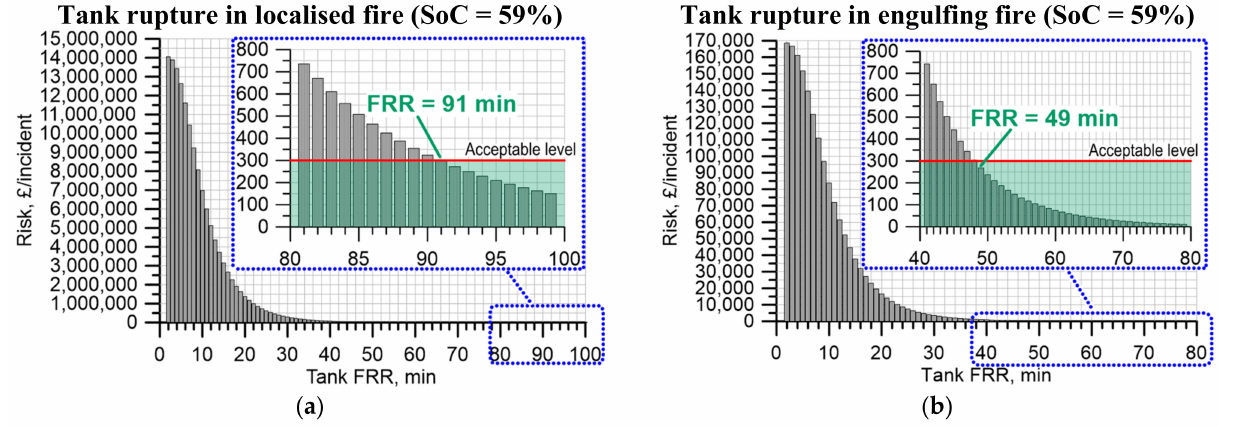
Figure 5. Risk (GBP/incident) as a function of hydrogen storage tank FRR for 62.4 L tank rupture at SoC = 59%: localised fire ( a ) and engulfing fire ( b